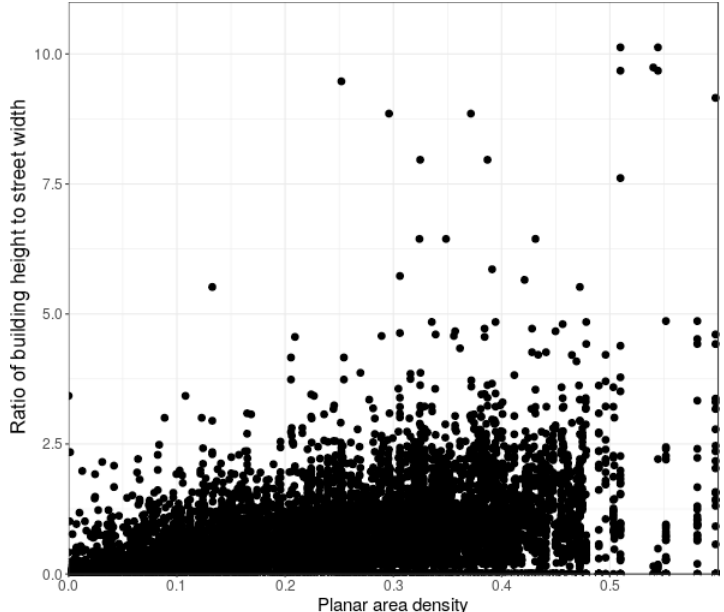
Figure A1. Scatter plot showing aspect ratio and building density relation in Barcelona